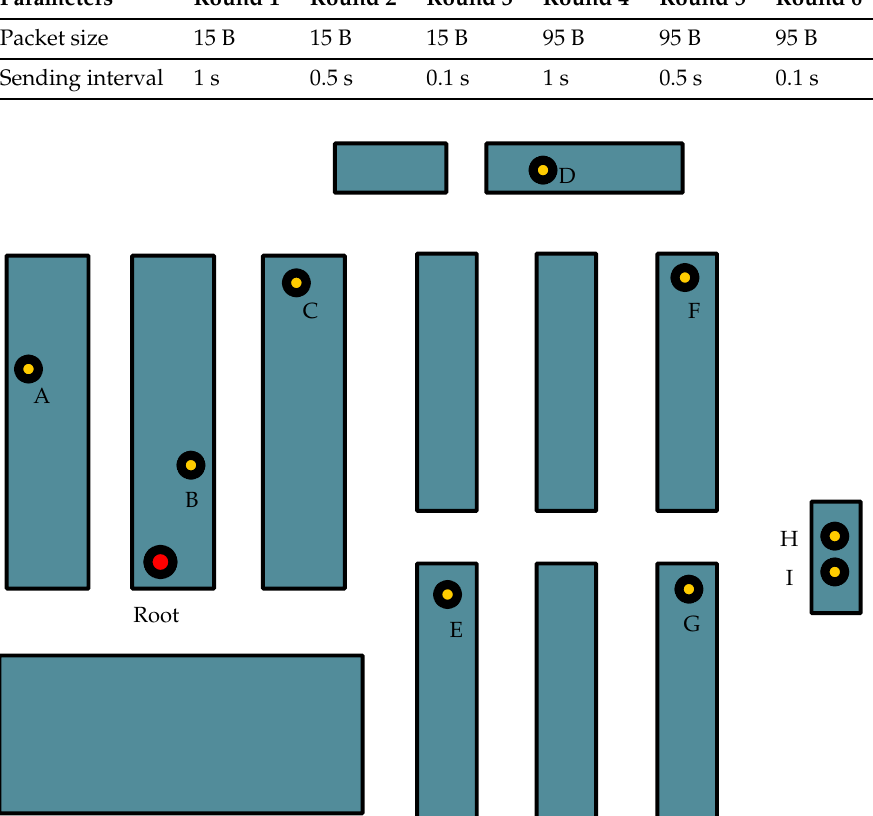
Figure 11. Distribution of the deployed sensor nodes for the routing protocol tests within the indoor scenario.